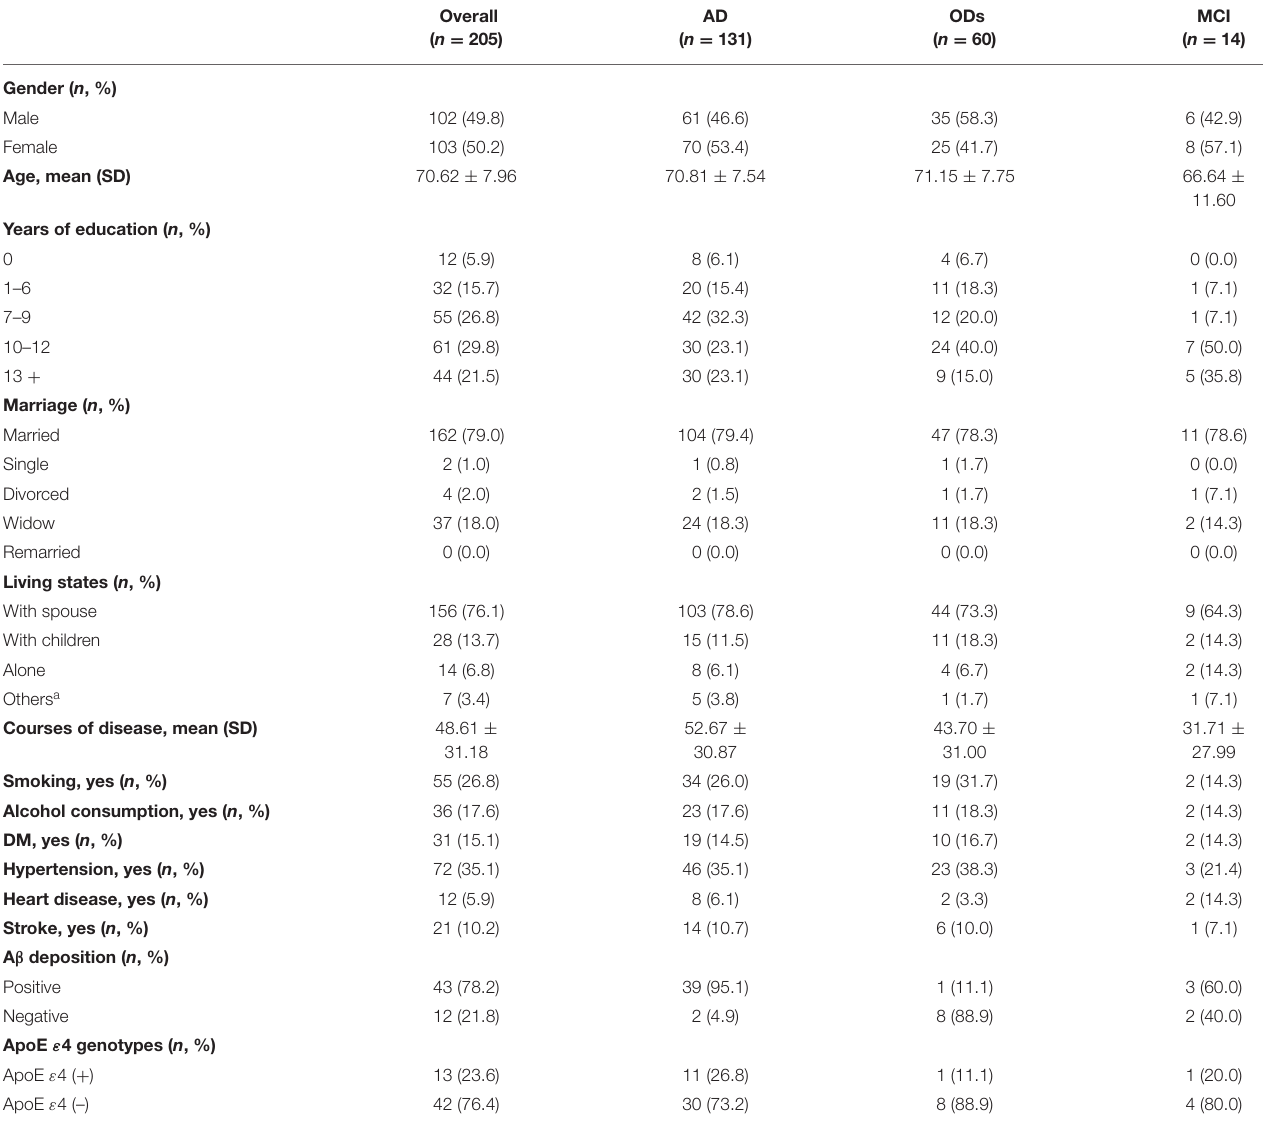
TABLE 1 | Baseline characteristics of the 205 patients with